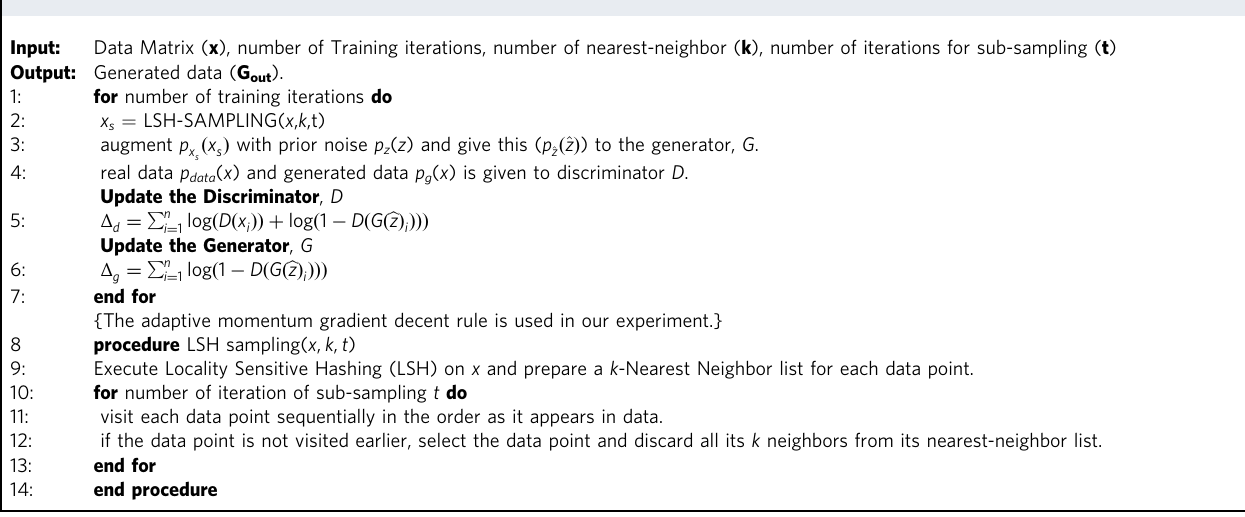
Table 1 LSH-GAN